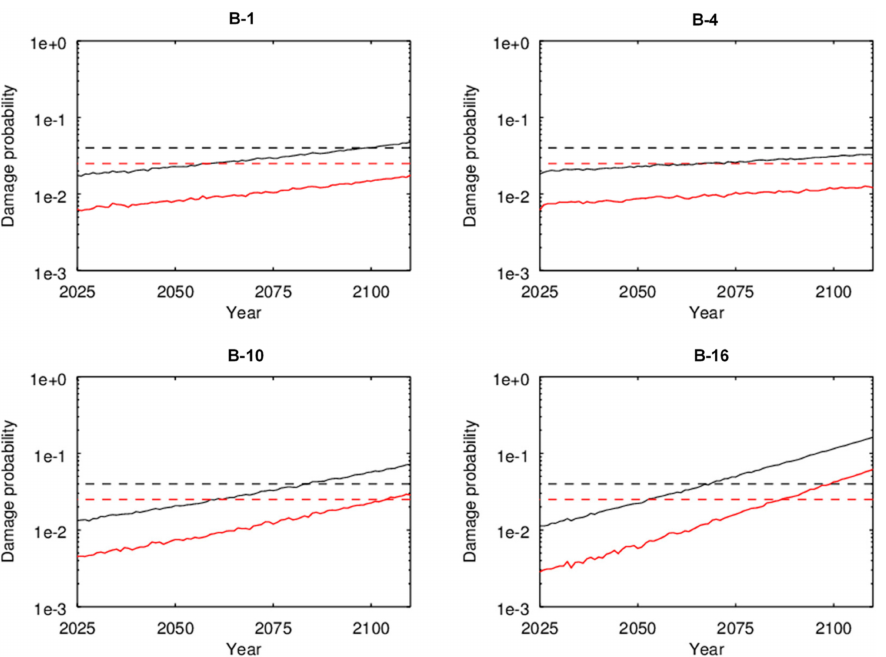
Figure 19. The annual probability of damage at the EOSL for selected profiles in Batticaloa (continuous lines) and the probability of damage above which retreat is optimal (dashed lines). The optimal investment horizon at the EOSL is found where these lines cross. Results for r = 8% per year in black; results for r = 5% per year in red.